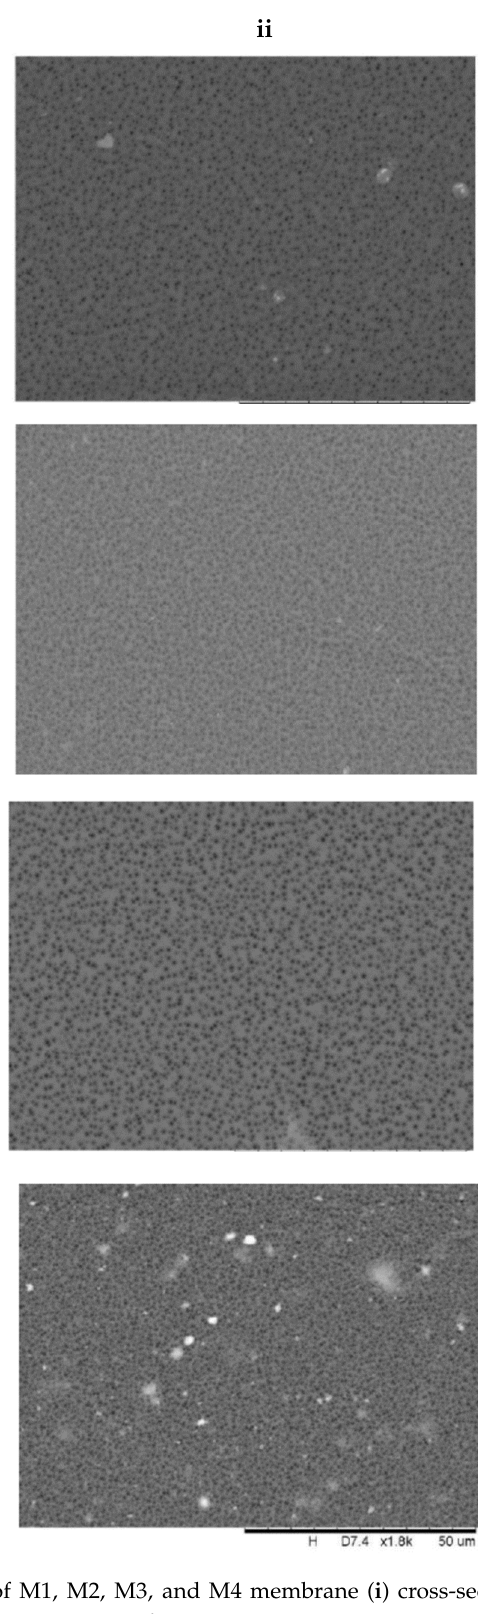
Figure 2. Membrane morphology of M1, M2, M3, and M4 membrane ( i ) cross-section at 500 × magnification and ( ii ) outer surface at 1800 × magnification.